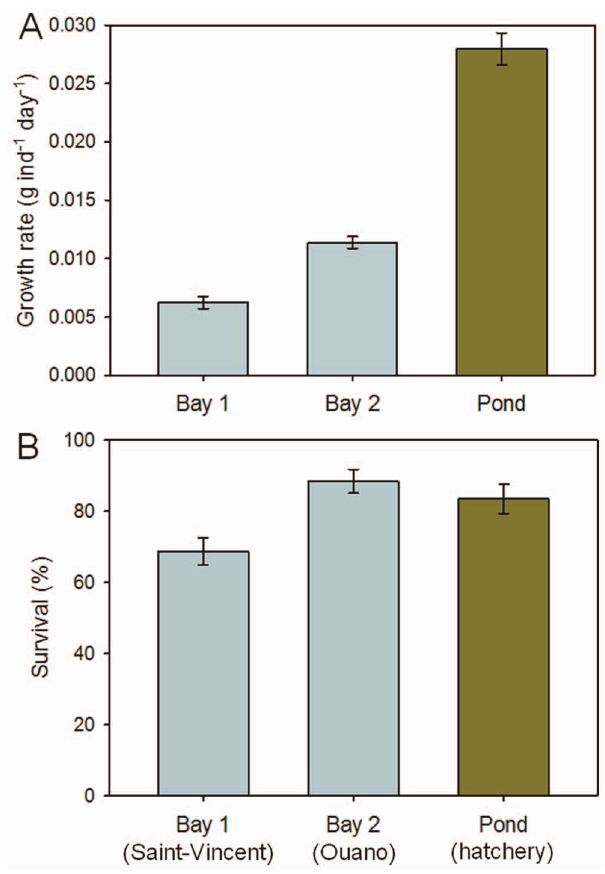
Figure 7. Enclosures at sea vs. pond. Bar graphs comparing (A) average growth rates and (B) average survival of sandfish in coarse- mesh enclosures at two sites at sea and those in an earthen pond; n =4. Error bars are 1 standard error of the